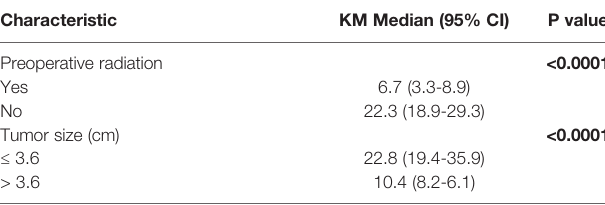
TABLE 4 | Risk factors for overall and progression fee survival in stage III locally advanced pancreatic cancer